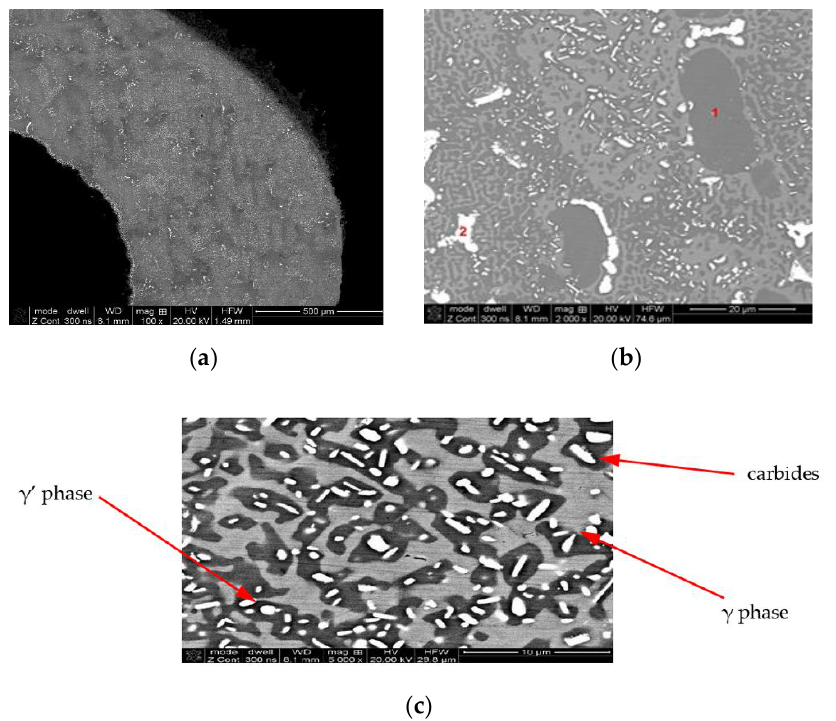
Figure 13. Damaged barrier coating at the leading edge of the HPT blade ( a ) and the effect of the anomalous growth of the γ’ phase ( b ) and increase in the share of carbides in the matrix of the core material ( c ) due to overheating.